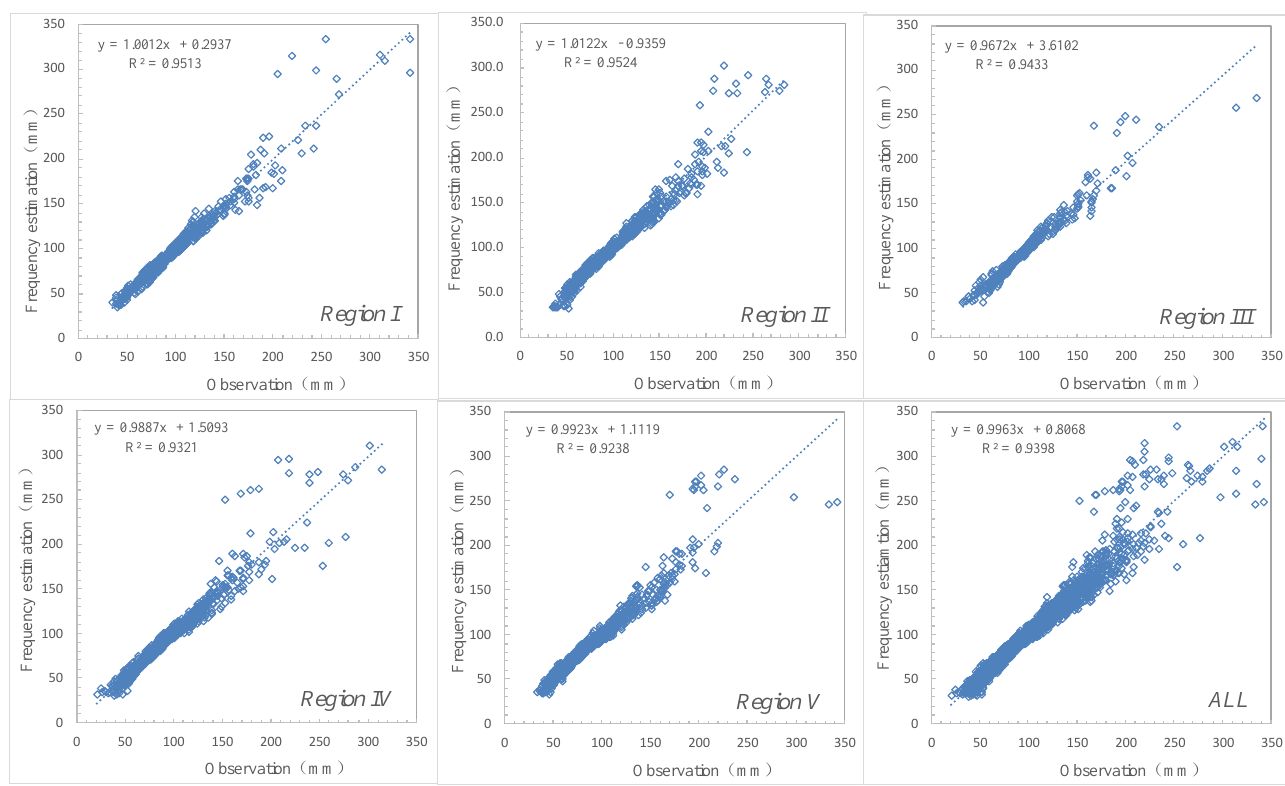
12 of 17 Table5. Comparisons between estimation and observation. Homogeneous Regions